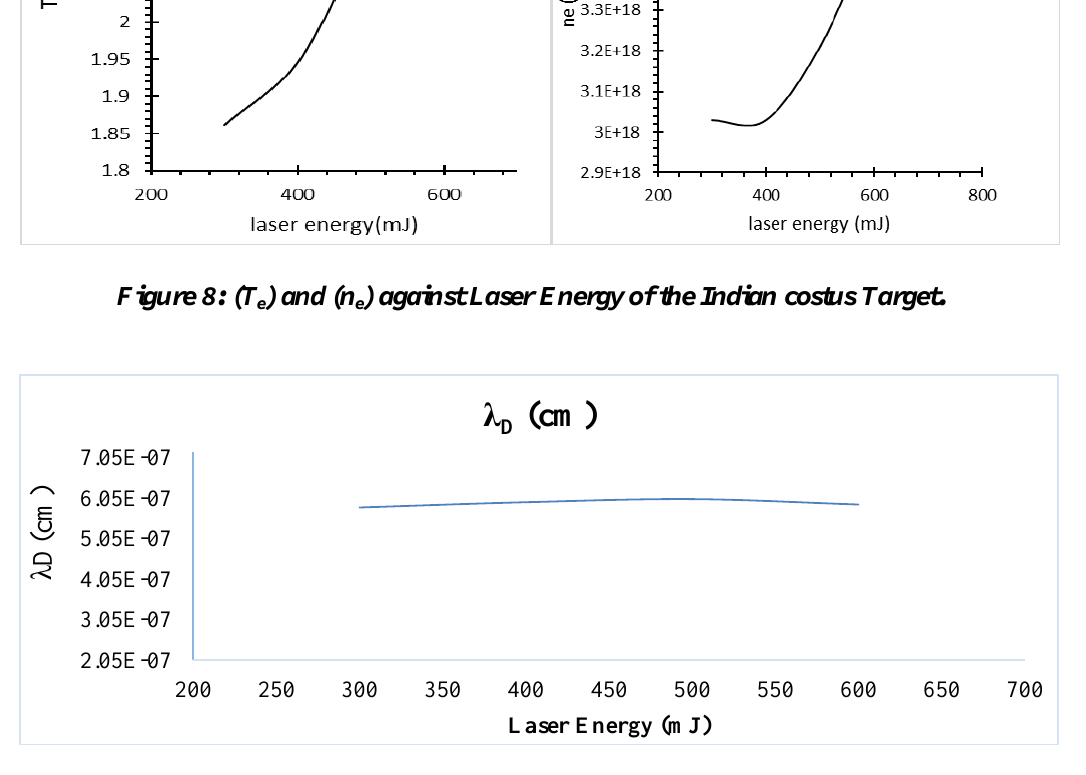
) and the plasma (f D